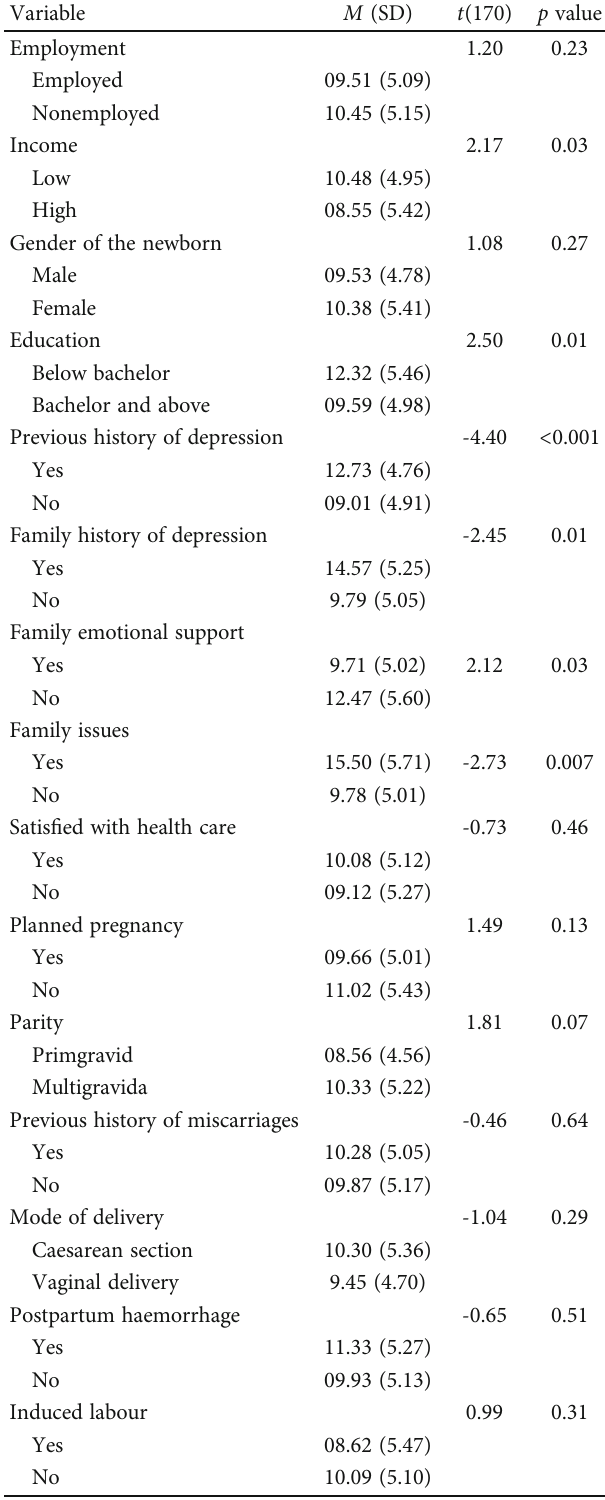
Table 3: Independent t -test to examine the di ff erence in Edinburgh Postnatal Depression Scale (EPDS) based on selected demographic, social and psychological, and clinical variables ( N = 172